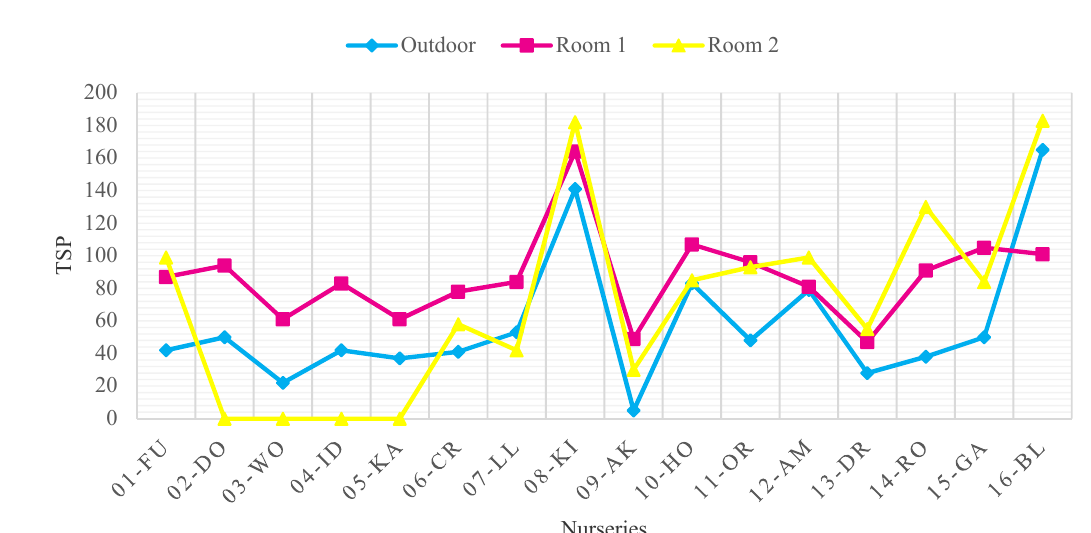
Figure 5. TSP concentration in each room and outside air before improvement (WHO Standard: 100 μ g/m 3 ). The TVOC concentration in the outside air of the target facilities was 512.89 μ g/m 3 in the case of the 15 ‐ GA, indicating a high level of pollution. In case of the rest of the nurse ‐ ries except for 15 ‐ GA, the average level of contamination was 125.06 μ g/m 3 , indicating below WHO IAQ standard. It was measured that 8 out of 16 facilities (02 ‐ DO, 05 ‐ KA, 07 ‐ LL, 08 ‐ KI, 09 ‐ AK, 14 ‐ RO, 15 ‐ GA) and 12 out of 32 classrooms exceeded the recommended standards. The place with the highest level of TVOC pollution was found to be Room 1 and Room 2 of the 15 ‐ GA facility. Each concentration was 1583.39 μ g/m 3 and 1,473.70 μ g/m 3 , which was more than three times the recommended standard of 400 μ g/m 3 (Figure 6).